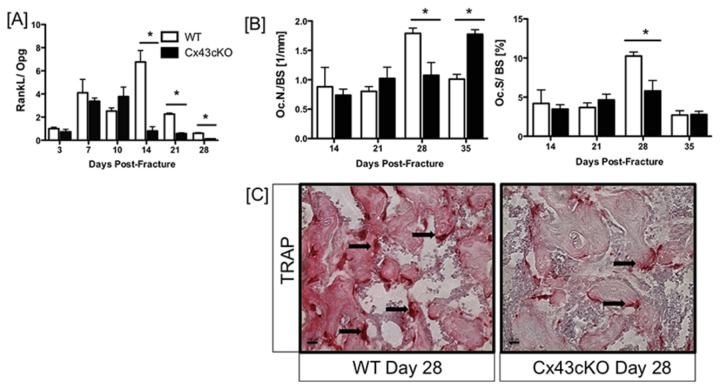
Impaired osteoclastogenesis in Cx43cKO fractures.[A] RankL/ Opg ratio calculated from qPCR analysis of RankL and Opg from tissue extracted from WT and Cx43cKO fracture calluses between 3-28 days. Tissue was pooled from 3 specimens/ genotype/ time-point, (*) indicates p<0.05 between WT and Cx43cKO at a given time-point. [B and C] Quantitative analysis of TRAP+ osteoclast number [B] and size [C] in WT and Cx43cKO fractures between 14-35 days. Cx43cKO fractures have significantly decreased Osteoclast number and Osteoclast surface at 28 days relative to WT. (*) indicates p<0.05 between groups at a given time-point, n=4 specimens/genotype/ time-point. [D] Representative images of TRAP stained sections of WT and Cx43cKO fractures at day 28 post-fracture. Black arrows indicate TRAP+ osteoclasts; scale bar represents 100μM.